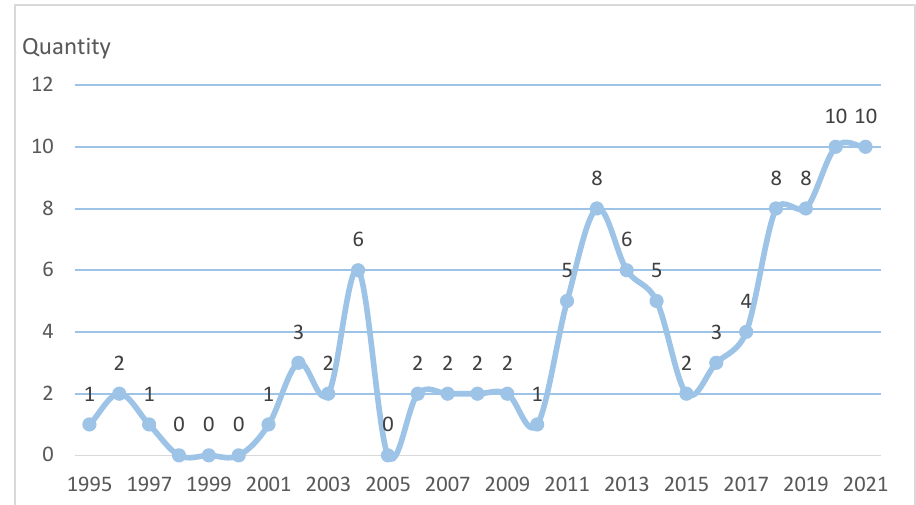
Figure 3. Yearly publications from 1995 to 2021.